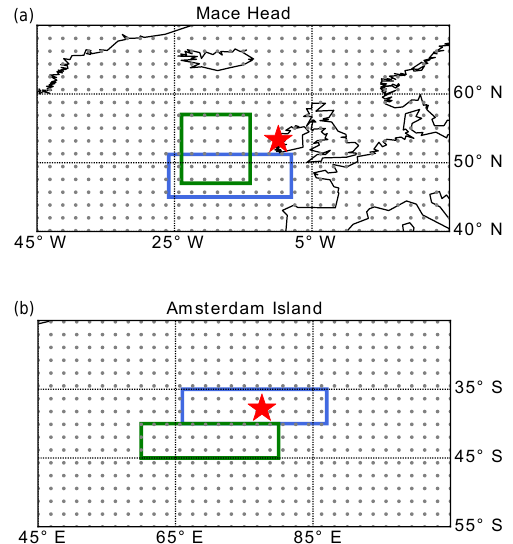
Figure A2. Source regions considered in offline calculations of MOA concentrations at Mace Head (a) and Amsterdam Island (b) according to various OMF parameterisations. The area boxed in green is the source region from the relevant publication related to each observational dataset, while that in blue is approximated from Vergara-Temprado et al. (2017). The red star indicates the location of the measurement station. The gray dots that fill the space are model grid points.